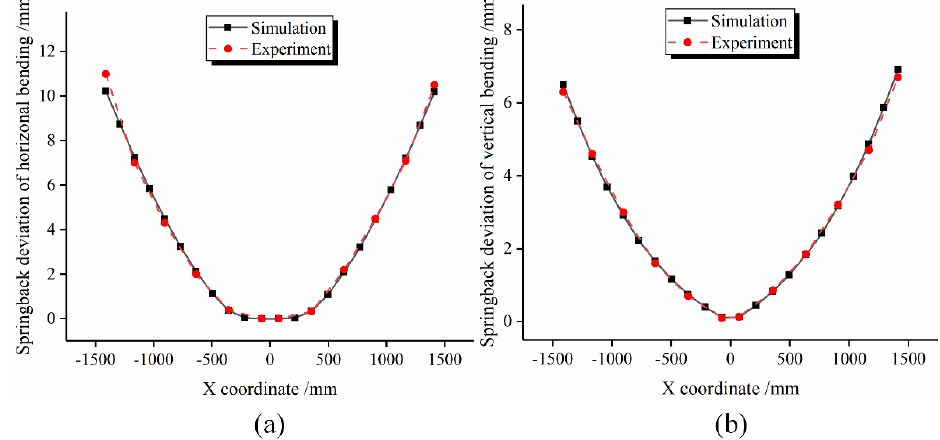
Figure 14. Comparison of springback deviation of Y-profile: ( a ) horizontal bending, ( b ) vertical bending.